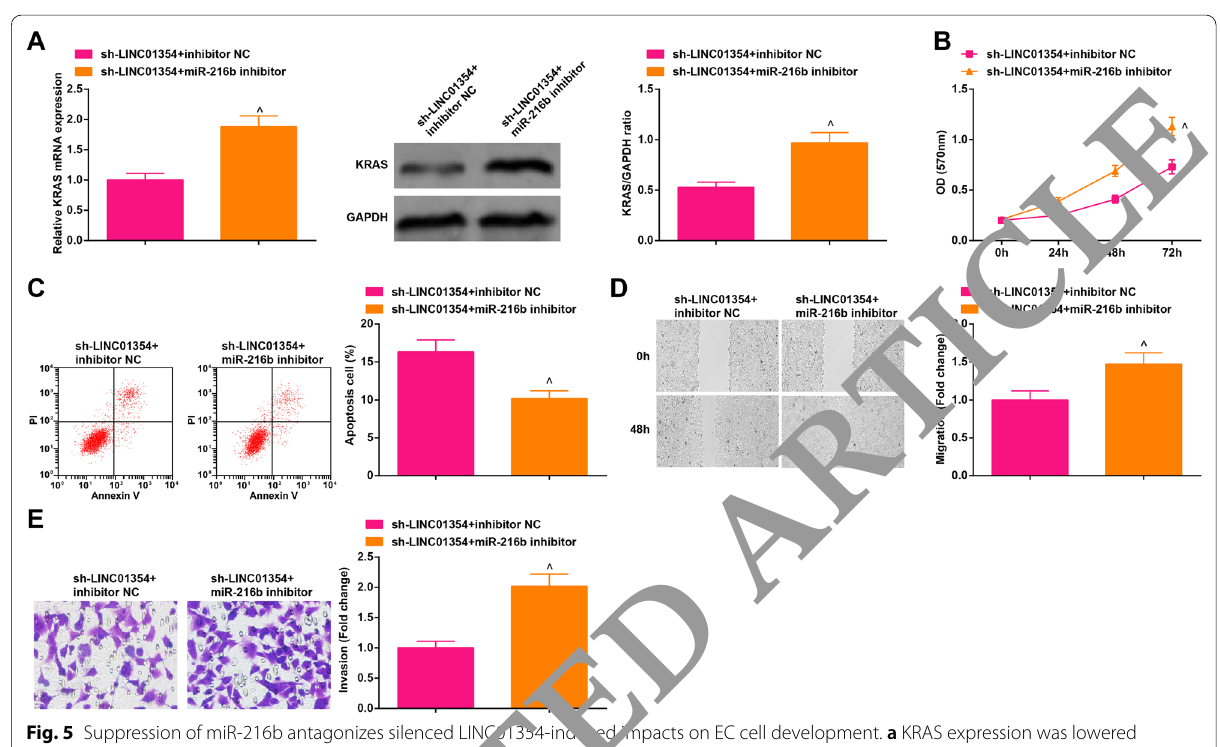
Fig. 5 Suppression of miR-216b antagonizes silenced LINC01354-induced impacts on EC cell development. a KRAS expression was lowered in lshikawa cells after silencing both LINC01354 and miR-216b (RT-qPCR and Western blot); b Cell viability was enhanced after silencing both LINC01354 and miR-216b (MTT assay); c Cell apoptosis rate was reduced after silencing both LINC01354 and miR-216b (flow cytometry); d Cell migration was accelerated after silencing both LINC01354 and miR-216b (scratch test); e Cell invasion was augmented after silencing both LINC01354 and miR-216b (Transwell assay). The data were expressed as mean sh-LINC01354 inhibitor NC +